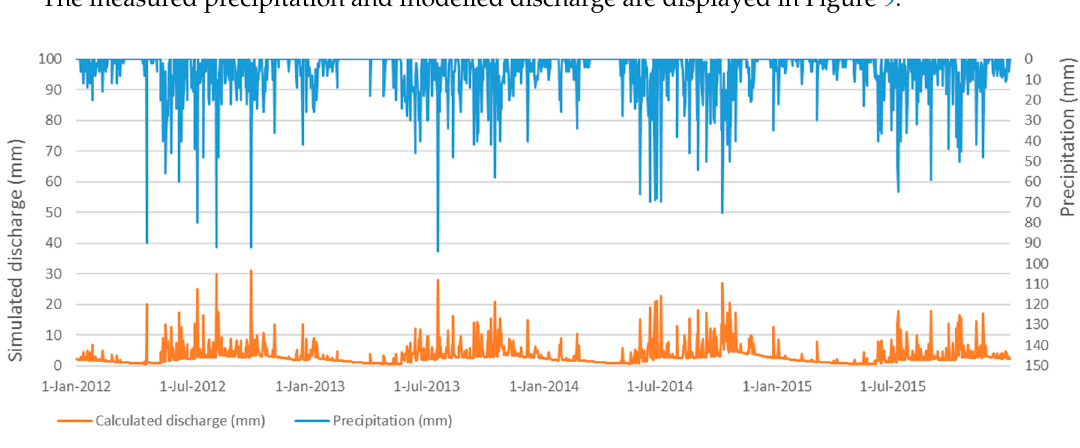
Figure 9. Precipitation ( top ) and discharge ( bottom ), 2012–2015.